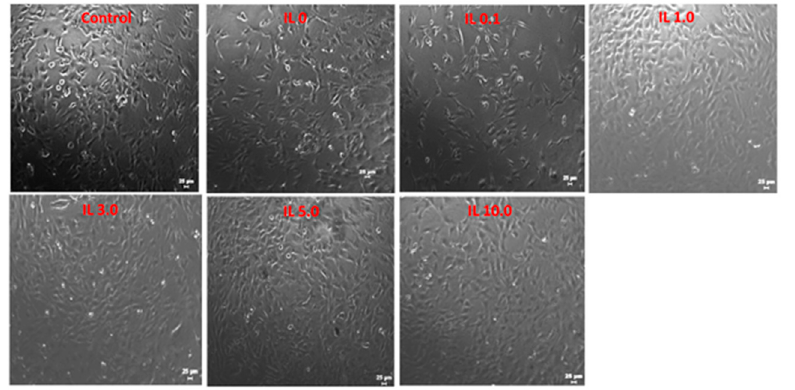
Figure 6. MTT assay of all the gel samples with 1 µg/mL concentration on Swiss and HaCaT cells, respectively.